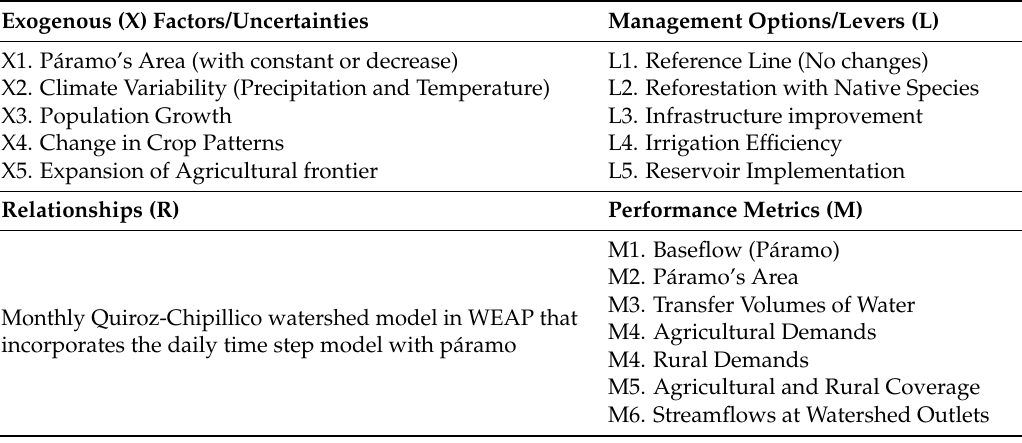
Table 3. XLRM results from participatory workshops in Quiroz-Chipillico